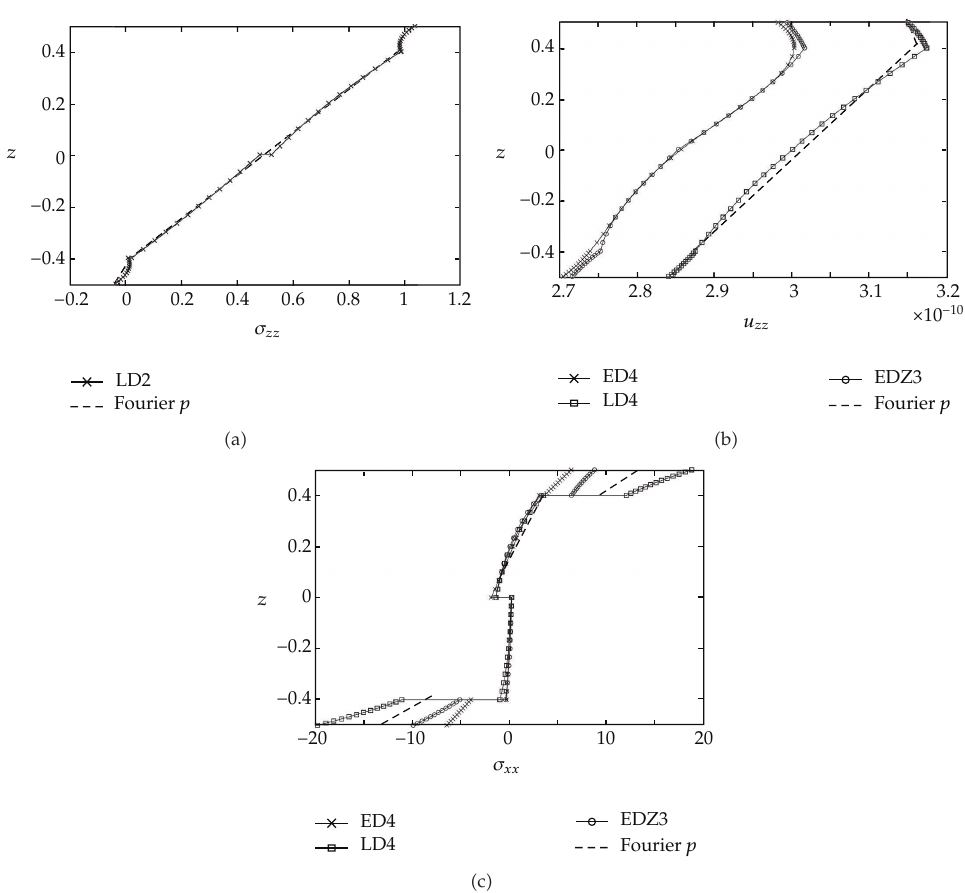
Figure 4: The comparisons between (cid:3) a (cid:6) the transverse normal stress, (cid:3) b (cid:6) transverse displacement, and (cid:3) c (cid:6) in-plane stress results of a sensor plate from the proposed method and (cid:4) 8 (cid:5) .